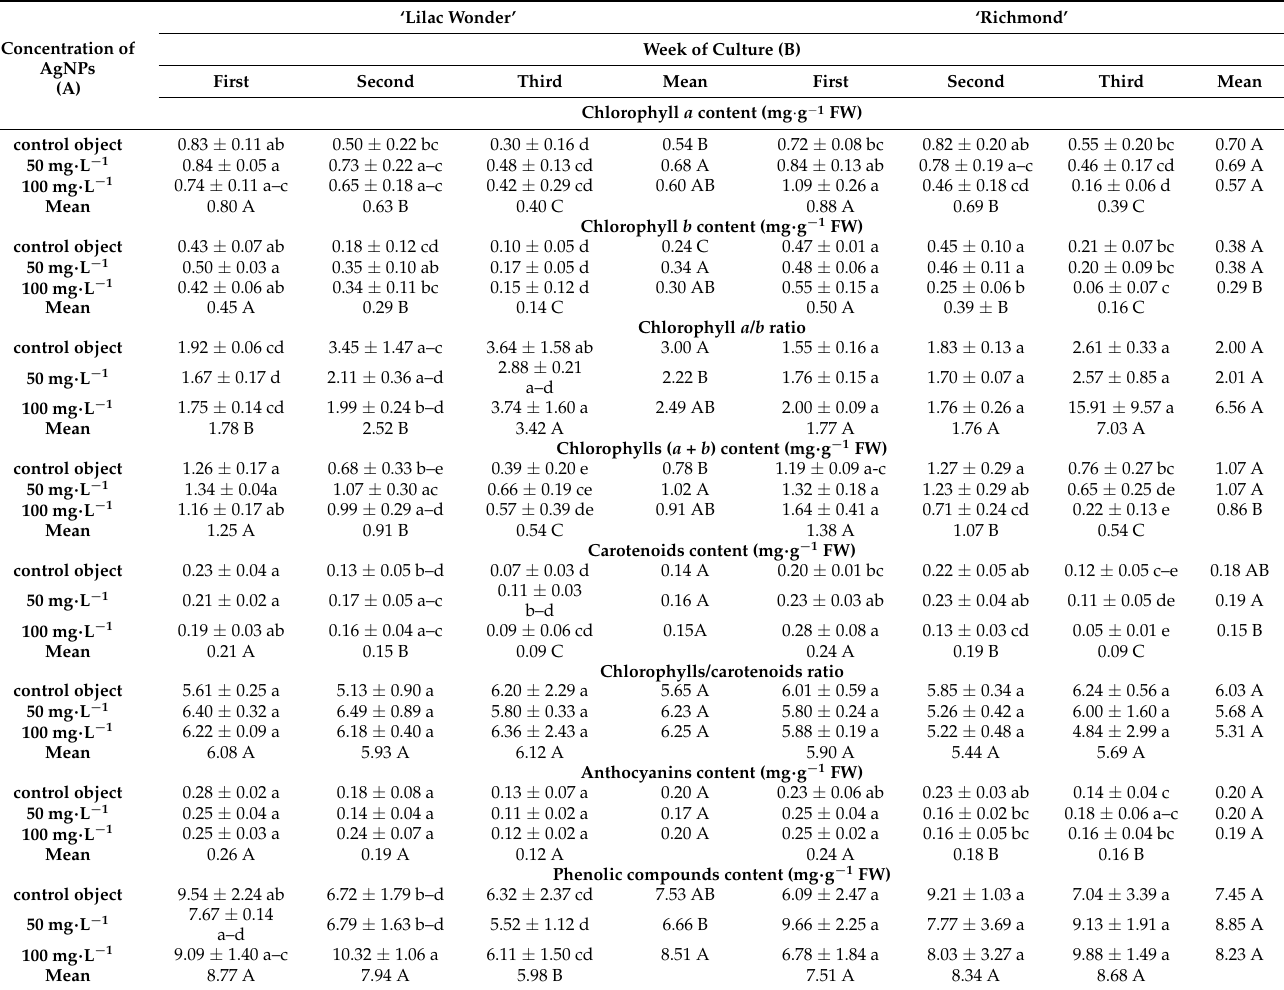
Table 1. Content of primary (chlorophyll a , chlorophyll b ) and secondary (carotenoids,